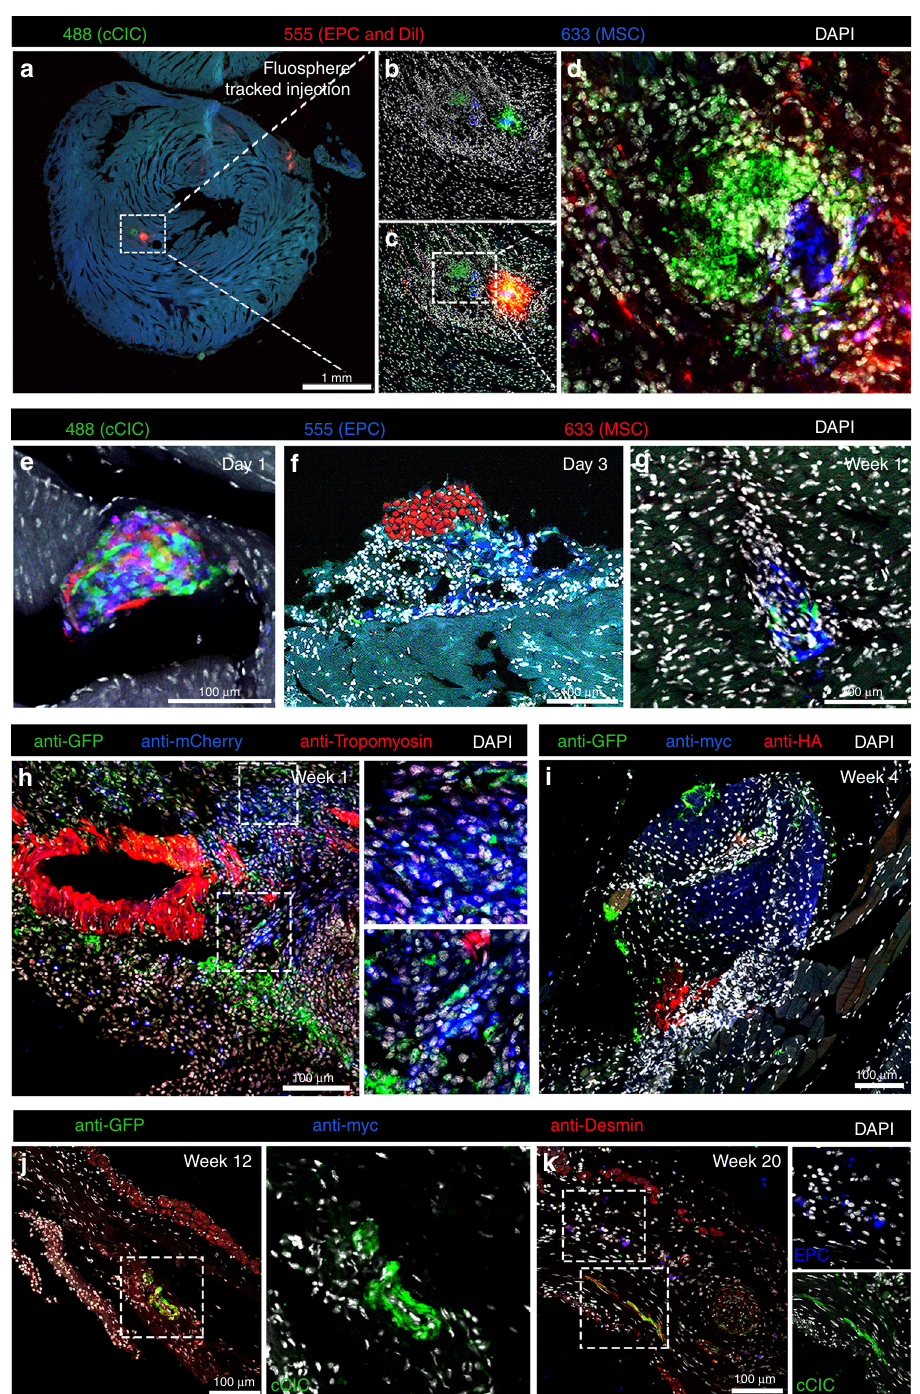
Fig. 6 CardioCluster show enhanced engraftment and persistence in the myocardial wall. a Immuno fl uorescent tile scan of a cryosectioned heart from an uninjured animal injected with CardioClusters day 3 post-injection tracked by FluoSpheres with no antibody labeling required for visualization of cells. b – d Higher magni fi cation of areas within white dotted boxes. b Illustrates the removal of the 555 nm channel in order to better visualize cCIC (green) and MSC (blue), without FluoSpheres. c , d In all, 555 nm channel restored ( c ) and fi eld of view magni fi ed ( d ). e – g Immuno fl uorescent images from cryosectioned MI hearts injected with CardioClusters at day 1 ( e ), day 3 ( f ), and week 1 ( g ). h – k Antibody labeled immuno fl uorescent images from MI hearts injected with CardioClusters at week 1 ( h ), week 4 ( i ), week 12 ( j ), and week 20 ( k ). h Right panels show higher magni fi cation of areas with white dotted boxes. j Right panel shows higher magni fi cation of cCICs shown within white dotted box. k Right panels show higher magni fi cation of cCICs and EPCs shown within white dotted boxes. Antibody labeling: anti-GFP labels cCIC, anti-mCherry labels EPC and MSC ( e ); anti-GFP labels cCIC, anti-myc labels EPC and anti-HA labels MSC ( f – h ). Scale bars: 1 mm ( a ); 100 μ m ( b – h